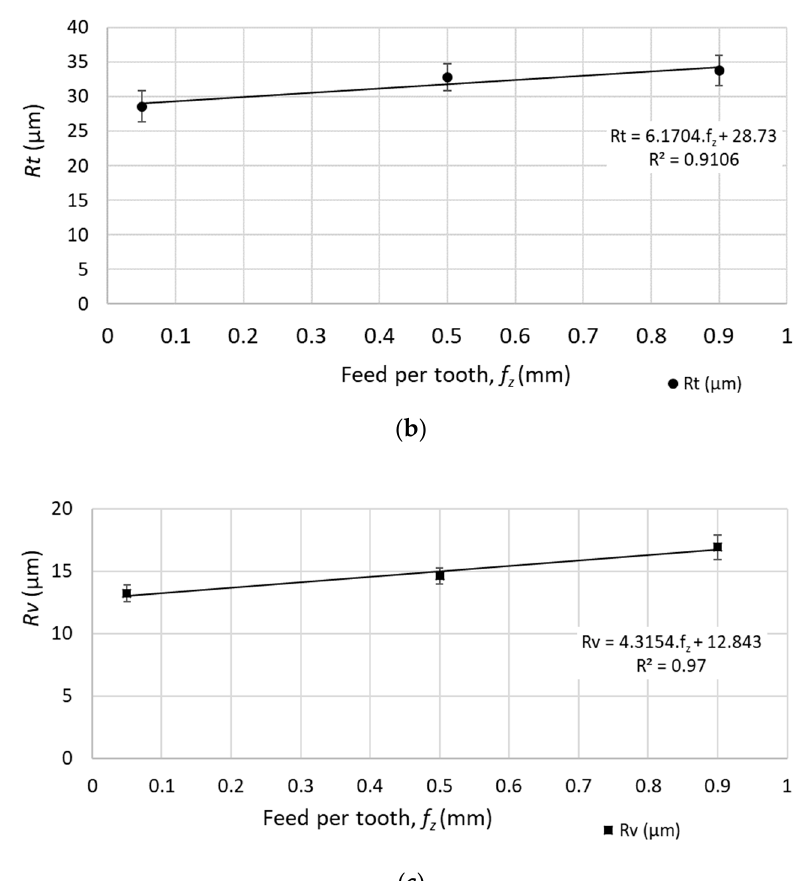
Figure 7. Selected profile roughness parameters for different feed speeds (at cutting speed v c = 200 m.min − 1 ): ( a ) Ra – Average roughness, Rq – root-mean-square roughness; ( b ) Rt - maximum peak to valley height of roughness profile; ( c ) Rv - maximum valley depth of roughness profile.